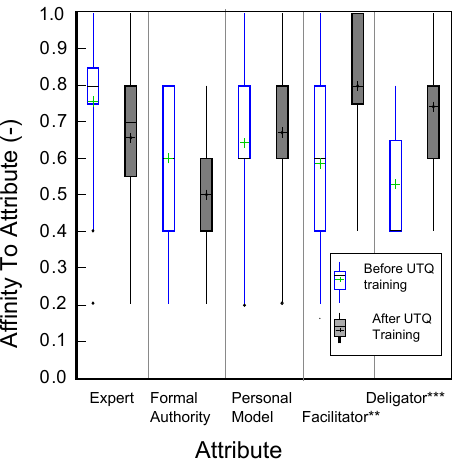
Fig. 4. UTQ graduates beliefs on what has changed in their teaching-styles after UTQ compared to before. ∗∗∗ p< 1%, ∗∗ p< 5%. Y-axis is on a scale from 0 to 1.0.